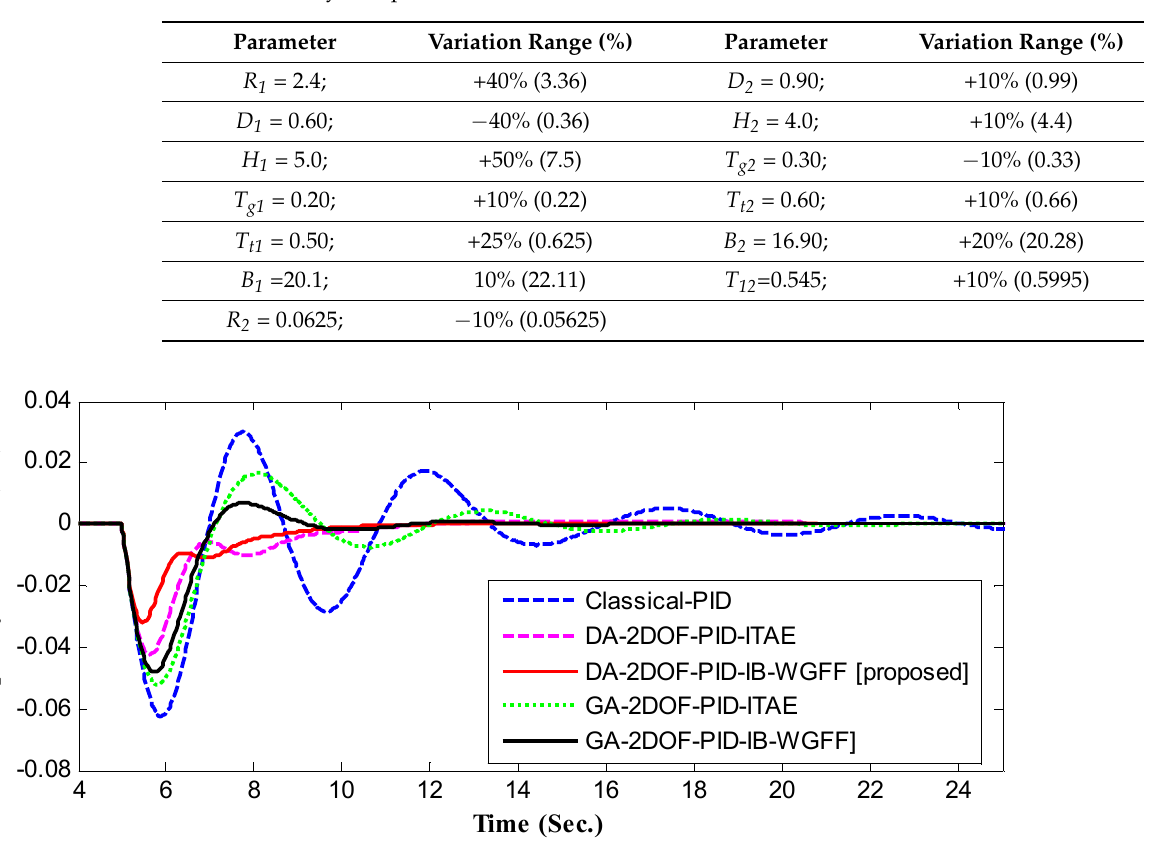
Table 9. Power system parameter variations.